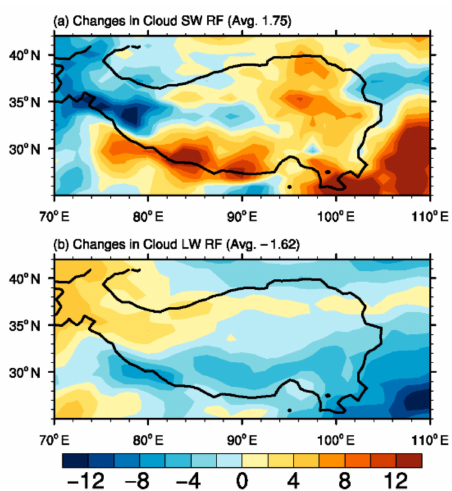
Figure 6. Changes in cloud radiative forcing (W / m 2 ) during summer for the period (2001–2005) for ( a ) Shortwave and ( b ) Longwave. The area of the TP is enclosed by a black line.